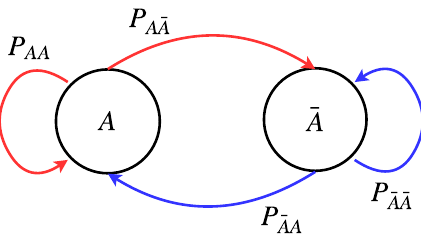
Figure 2. Two-state Markov discrete-time model for the primary user’s states. P i , j : i , j ∈ { A , ¯ A } : the transition probabilities between the